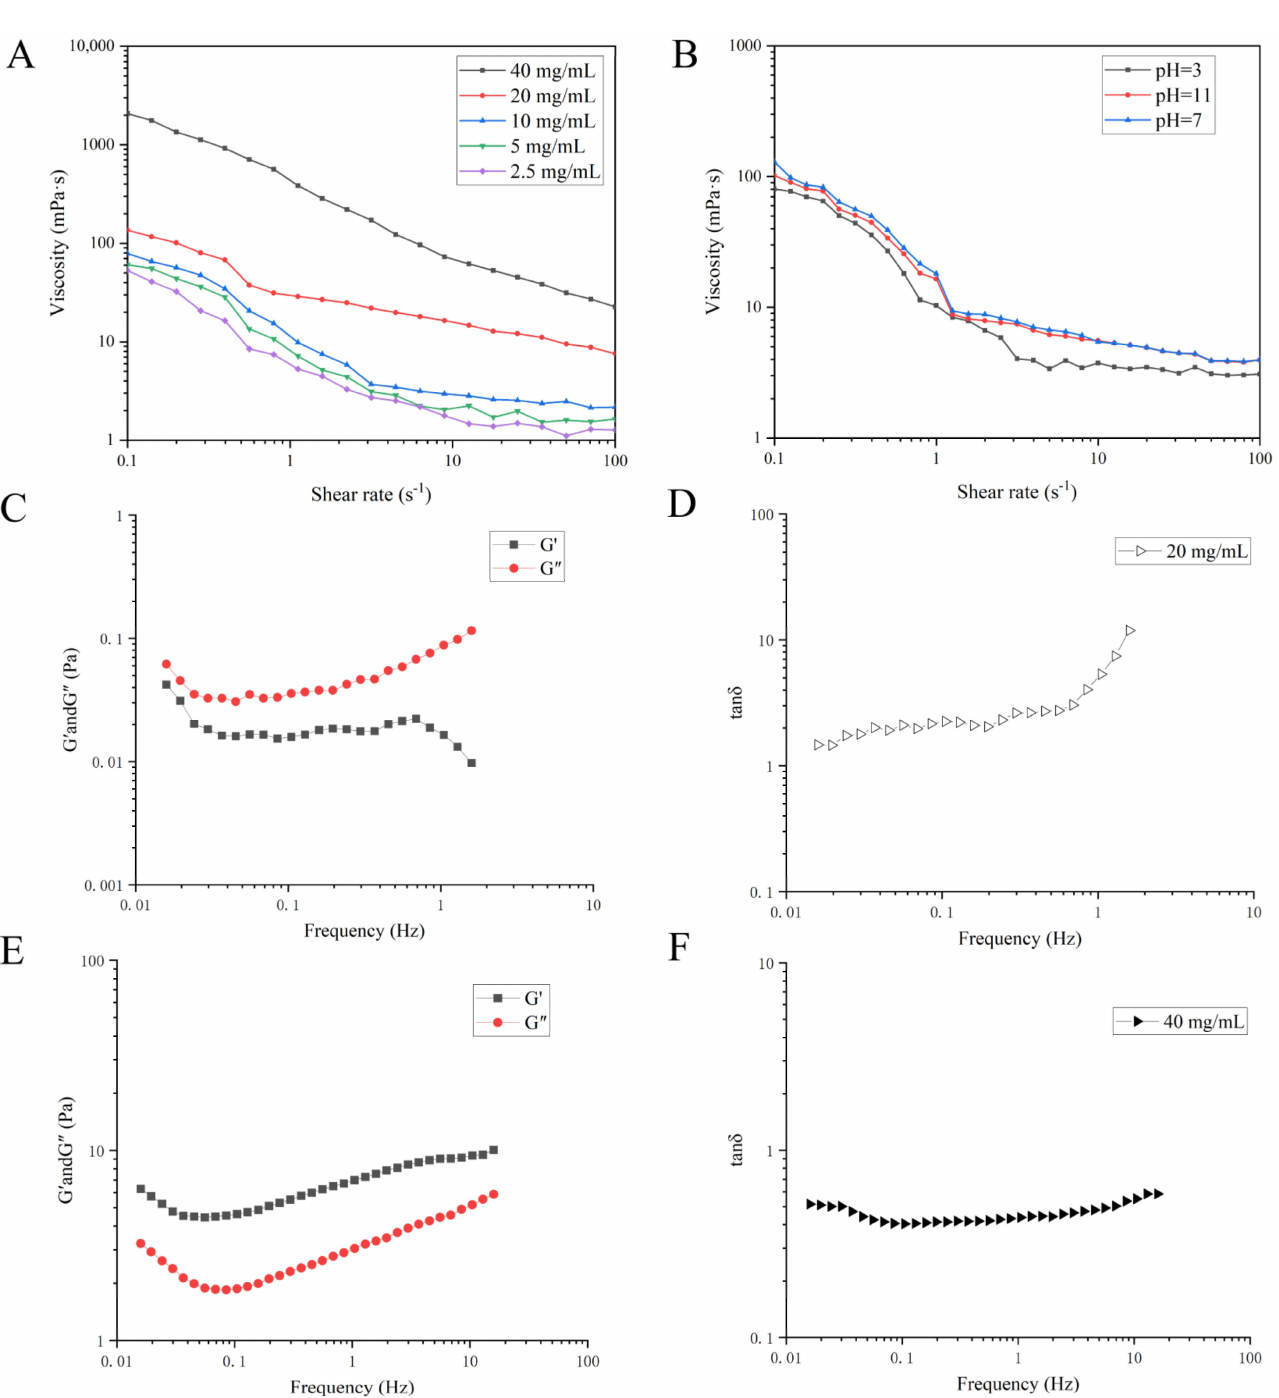
Figure 2. The rheological measurements of BJP-4: ( A ) Variation in apparent viscosity of different concentration BJP-4 with shear rate. ( B ) Variation in apparent viscosity of 20 mg/mL BJP-4 with pH change. ( C ) Frequency sweeps performance at 50% strain for determining the storage modulus G (cid:48) and loss modulus G (cid:48) for 20 mg/mL BJP-4 solution. ( D ) The tan δ of 20 mg/mL BJP-4. ( E ) Frequency sweeps performance at 5% strain for determining the storage modulus G (cid:48) and loss modulus G (cid:48)(cid:48) for 40 mg/mL BJP-4 solution. ( F ) The tan δ of 40 mg/mL